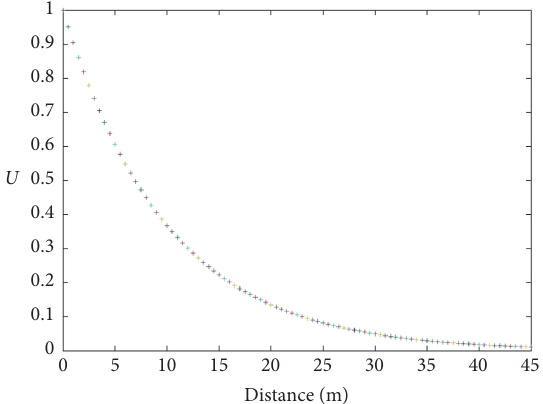
Figure 3: Barrier distance correlative function.